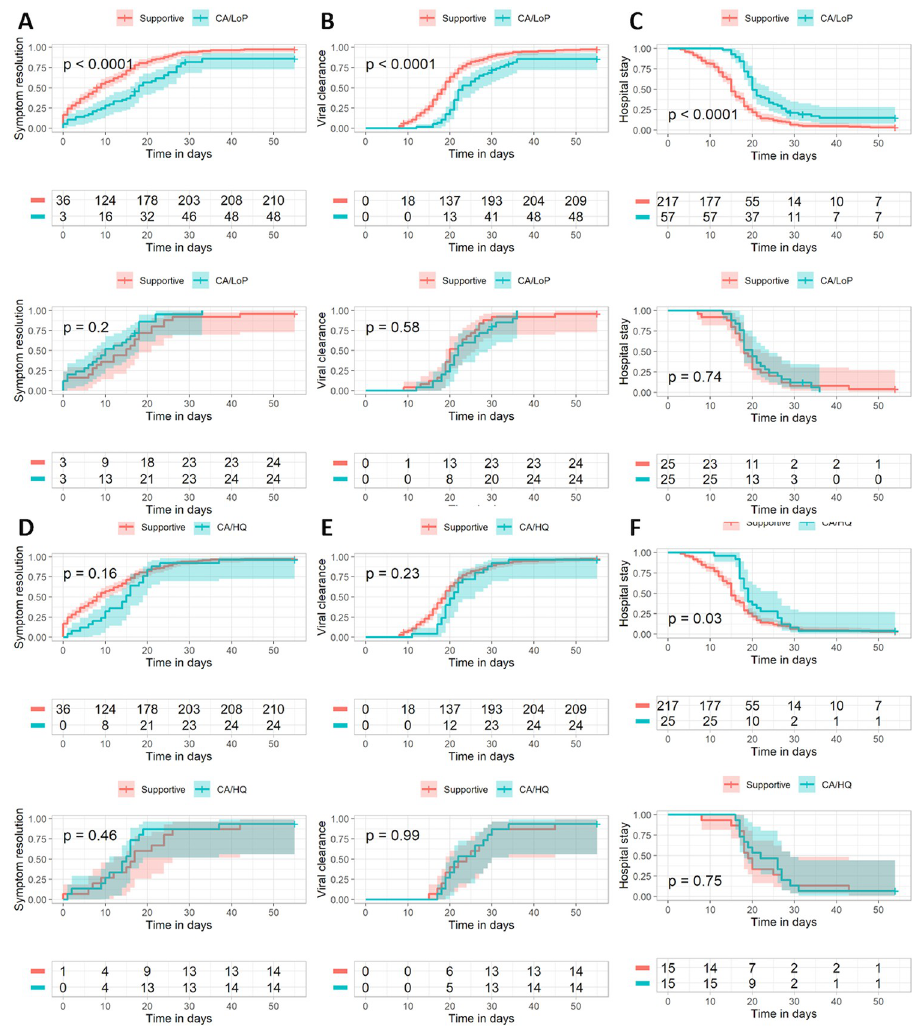
Fig 2. Kaplan-Meier curves regarding the three endpoints: Time to symptom resolution, time to viral clearance, and hospital stay duration, comparing CA/LoP vs standard group (A-C) and CA/HQ vs standard group (D-F). A-C: CA/ LoP vs Standard group D-F: CA/HQ vs Standard group A, D: Time to Symptom resolution B, E: Time to viral clearance C, F: Hospital stay duration.